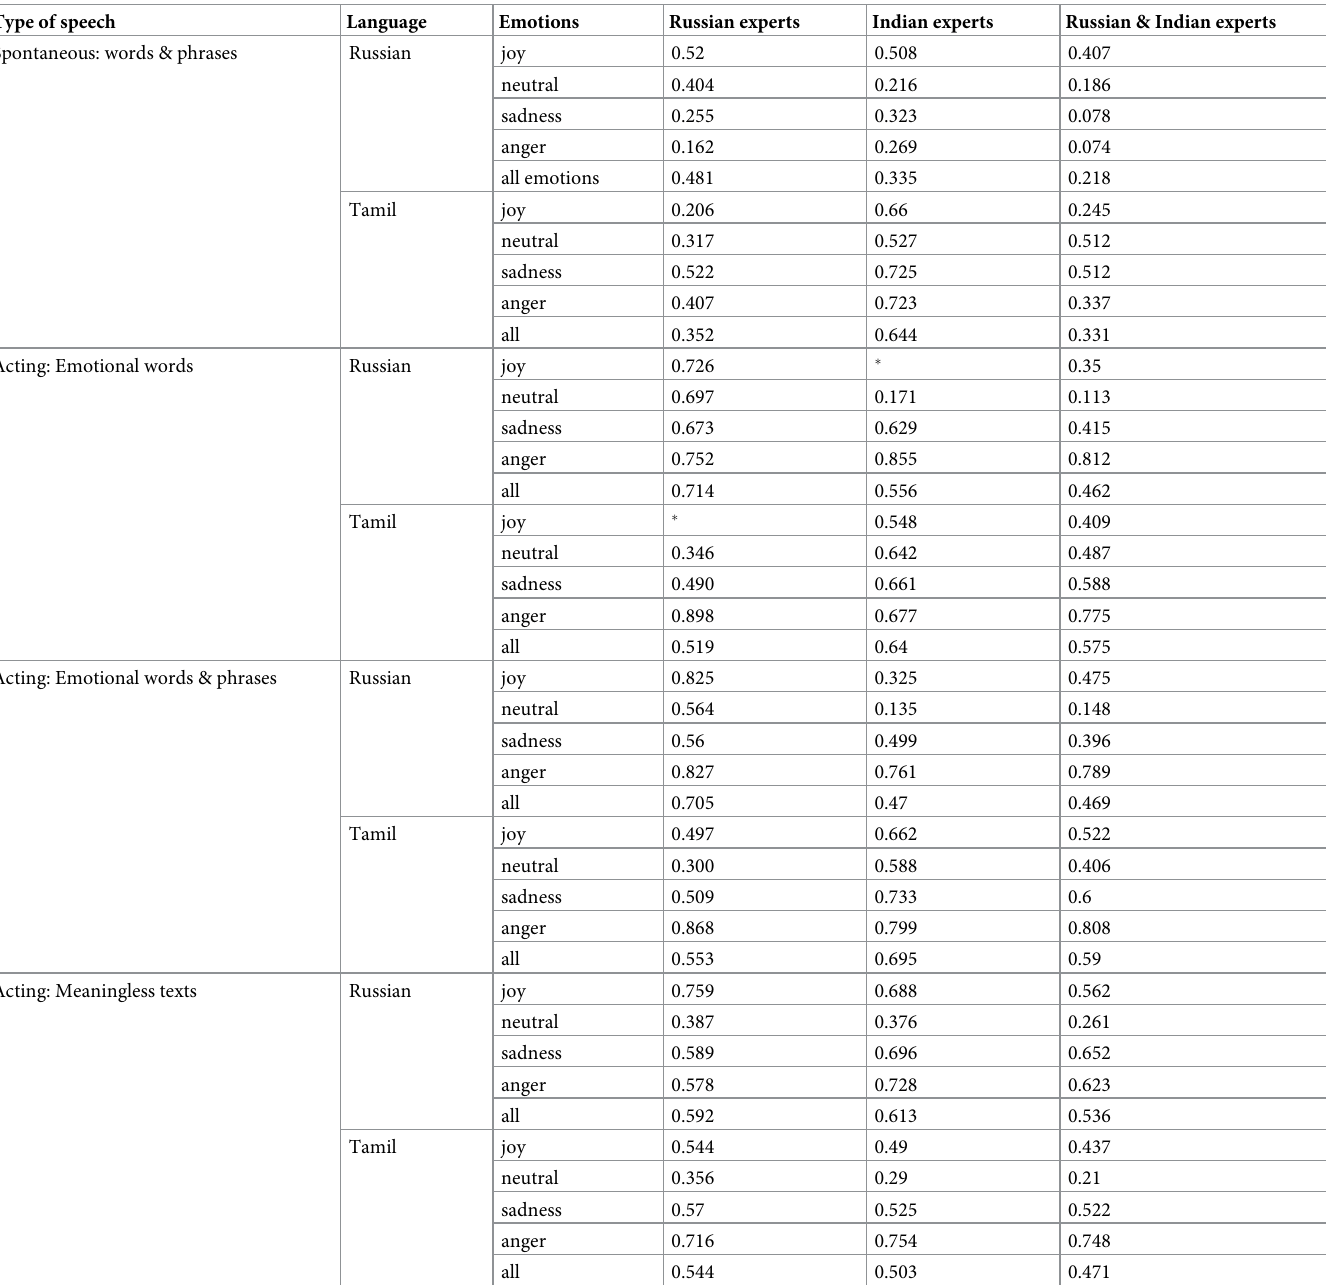
Table 12. Expert’s agreement in recognizing the emotional states of children via speech: Within a language group and between groups (Cohen kappa statistic). Type of